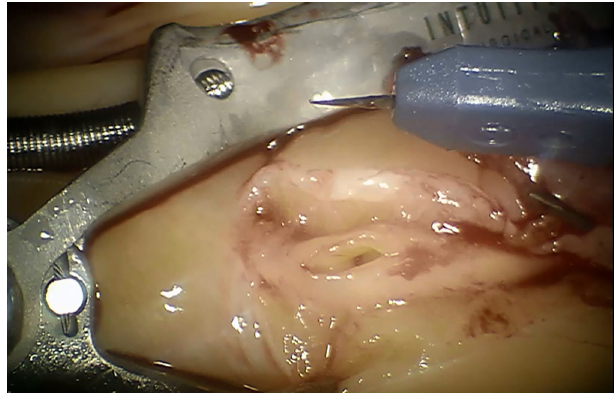
Fig. 1 - Opening of coronary artery (LAD) with endoscopic scalpel.